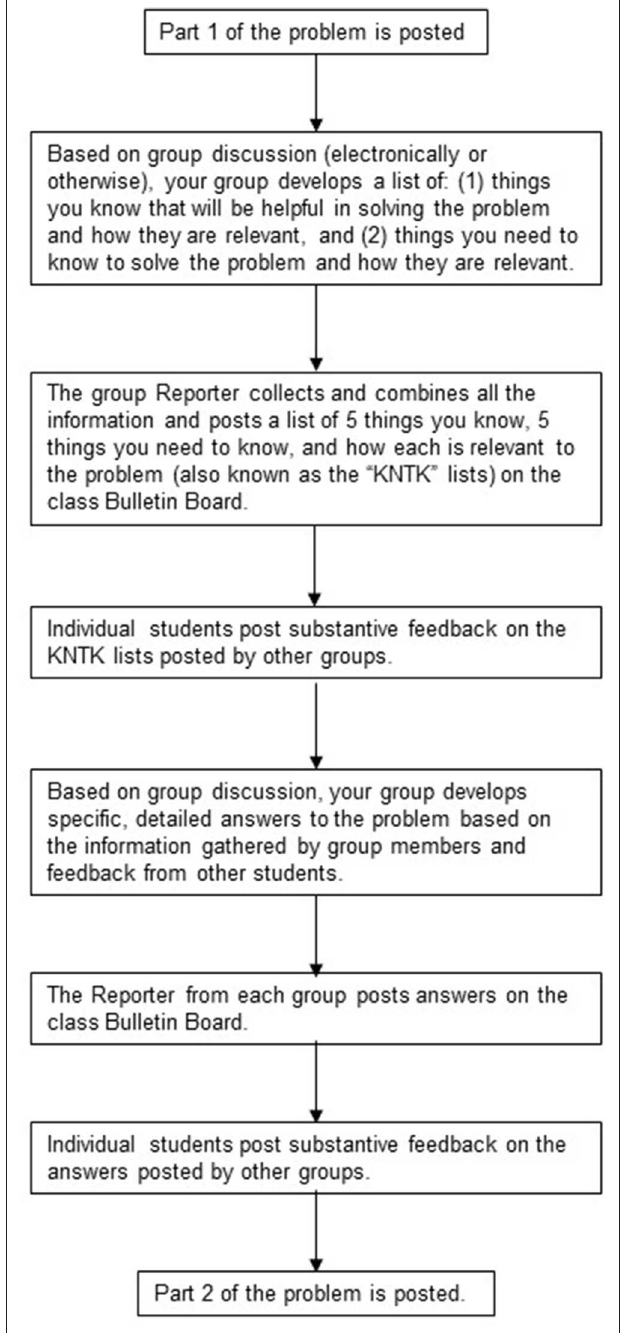
FIGURE 2 | Sequence of events in a problem-based learning asynchronous online course.